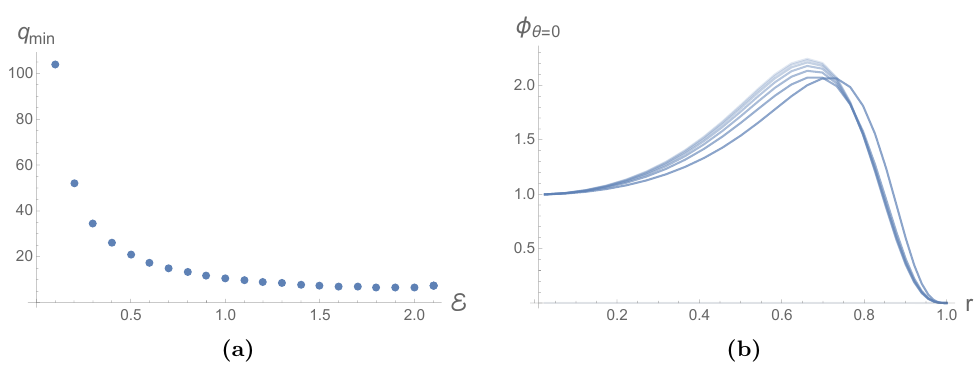
Figure 23. Instability onset for a charged scalar in a polarized soliton background. The plot on the left shows the critical value of q at which the instability occurs as a function of the electric (cid:12)eld. The plot on the right shows the scalar (cid:12)eld pro(cid:12)le at the pole as a function of the coordinate r for a range of electric (cid:12)eld values.